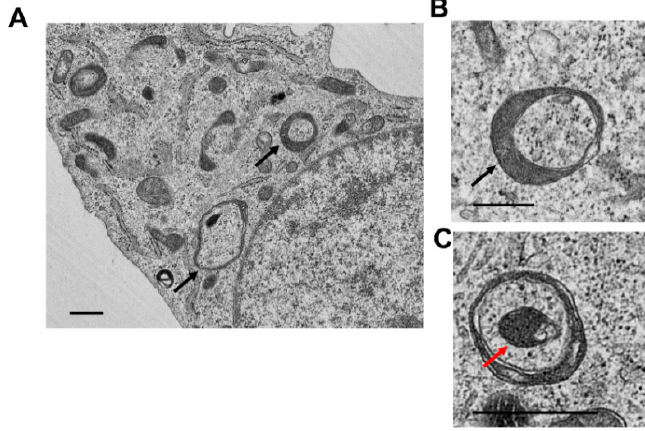
Figure 2. The structure of the mitochondrial spheroids under electron microscopy (EM). Wild-type mouse embryonic fibroblasts (MEF) were treated with CCCP (20 µ M) for 16 h. Cells were fixed and further processed for EM analysis. Representative EM images of a MEF ( A ), typical mitochondrial spheroid structures ( B , C ). Black arrows denote mitochondrial spheroids and the red arrow denotes mitochondria spheroid-enwrapped mitochondria.